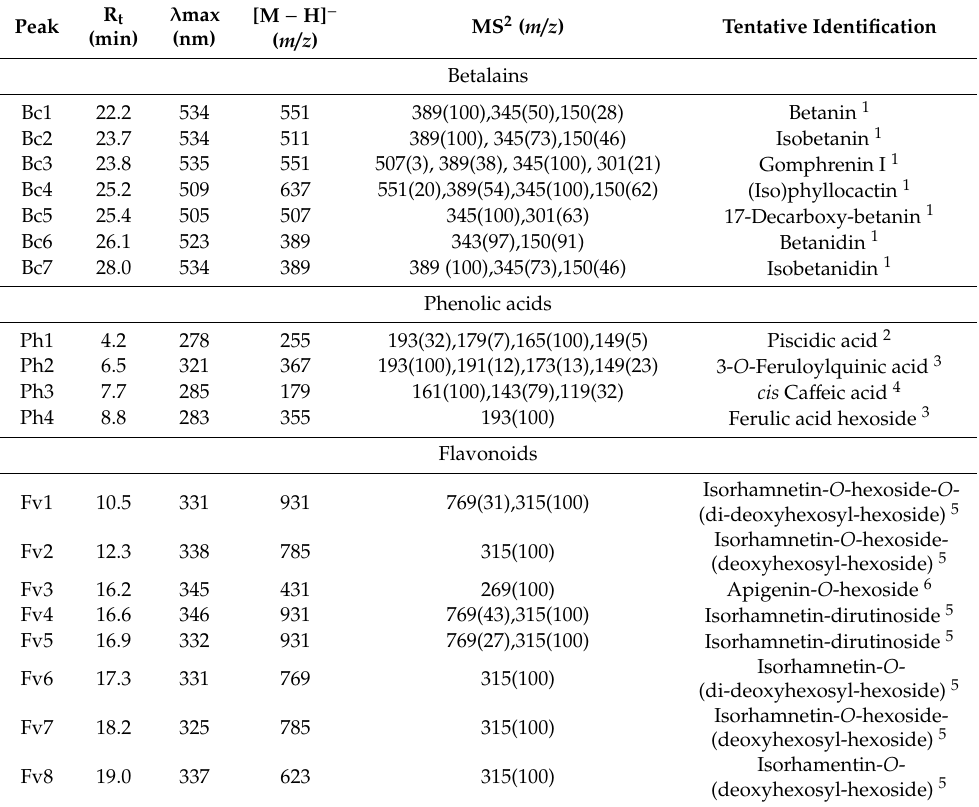
Table 1. Chromatographic and mass characteristic of the tentative identification bioactive compounds in the Opuntia engelmannii cv Valencia